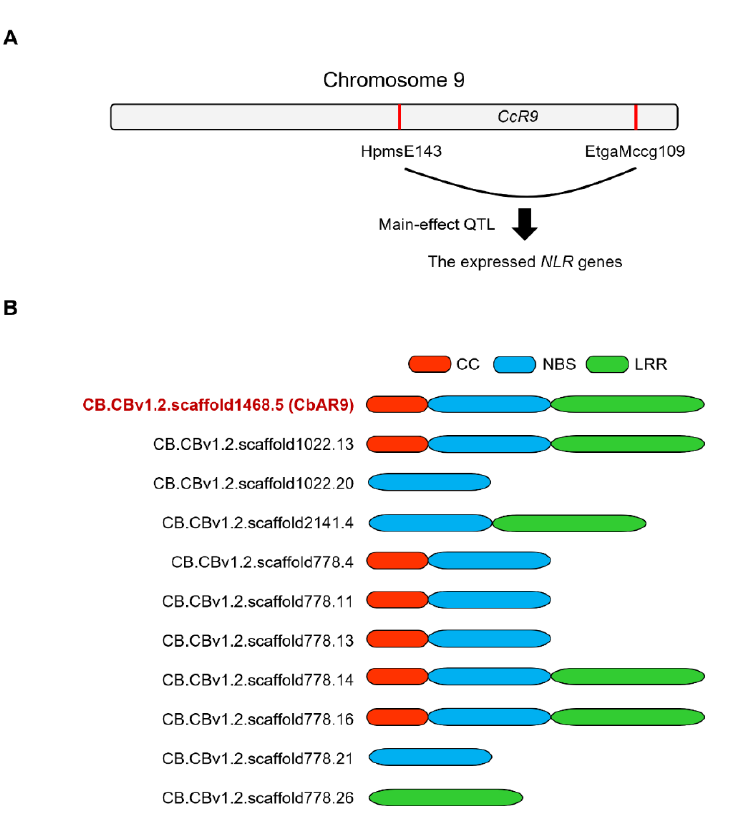
Figure 1. NLR-encoding candidate genes identified from the main-effector QTL of Capsicum baccatum resistant variety PBC80. ( A ) Schematic diagram of the identification of CbAR9 as the main-effect QTL CcR9 on chromosome 9 of the C. baccatum resistant variety PBC80. ( B ) Schematic representation of the identified candidate NLR proteins identified from the main-effector QTL of C. baccatum resistant variety PBC80. Red, CC domain; blue, NBS domain; green, LRR domain.